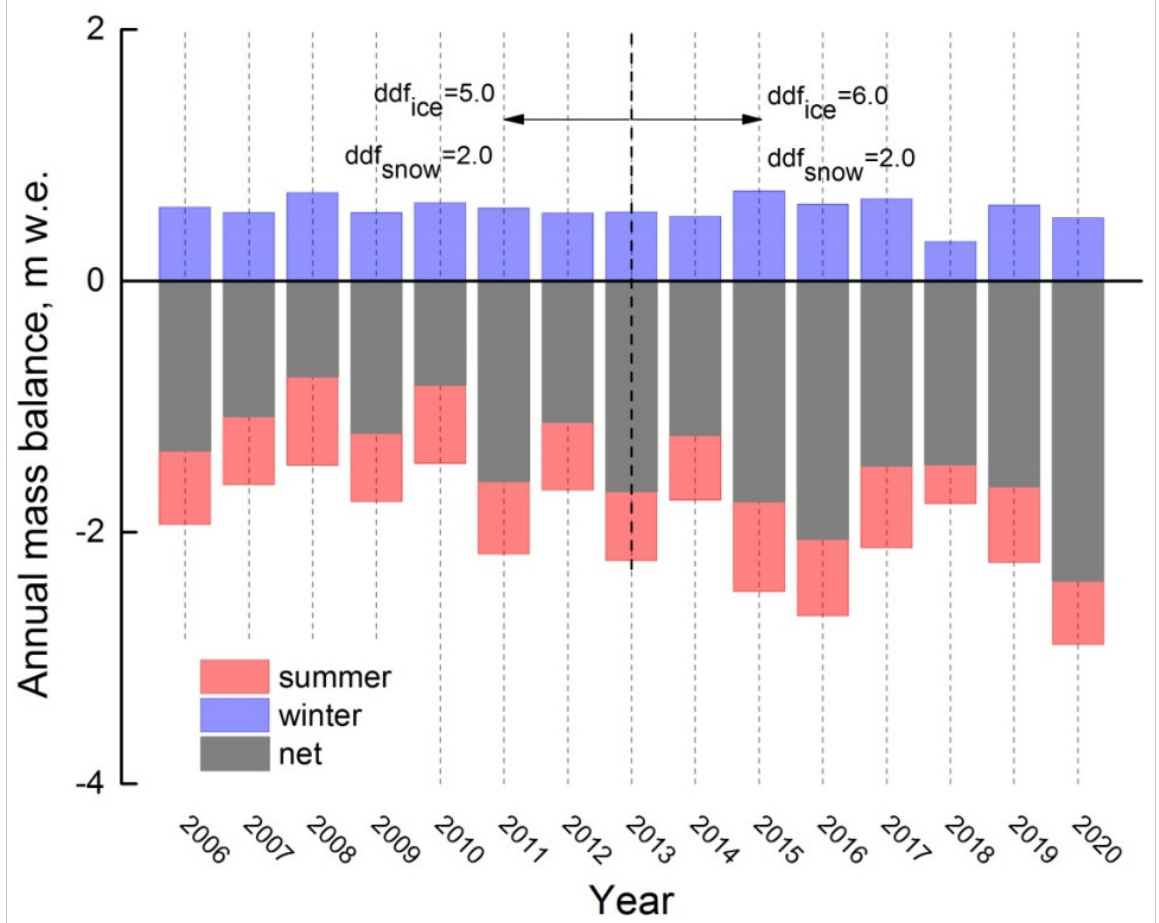
Figure 8. Reconstructed summer, winter balance and net balance of Austre Grønfjordbreen from 2006 to 2020.